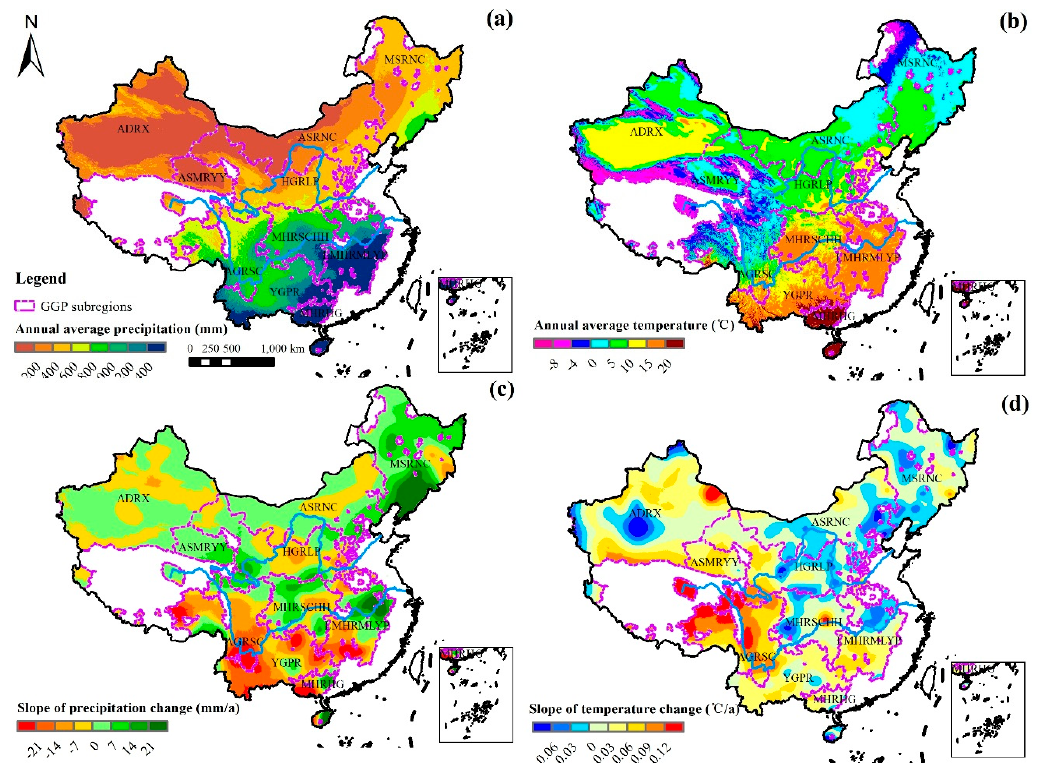
Figure 9. Spatial pattern of annual average climate and slope of climate change in the Grain for Green Program (GGP) area from 2000 to 2010. ( a , b ) are the annual average precipitation and temperature, respectively; ( c , d ) refer to the slope of annual precipitation and temperature changes, respectively.